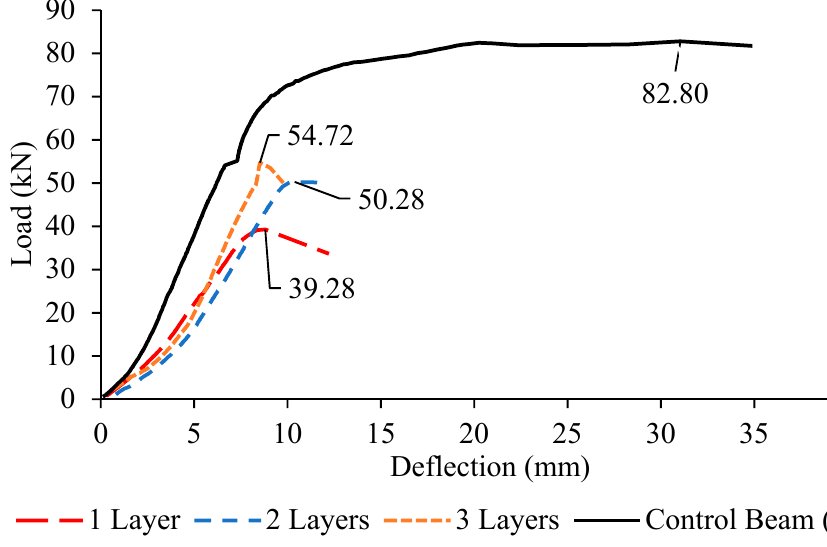
Figure 18. Load–deflection curves for Group 3 (B3a–B3c) deep beams and control beam.